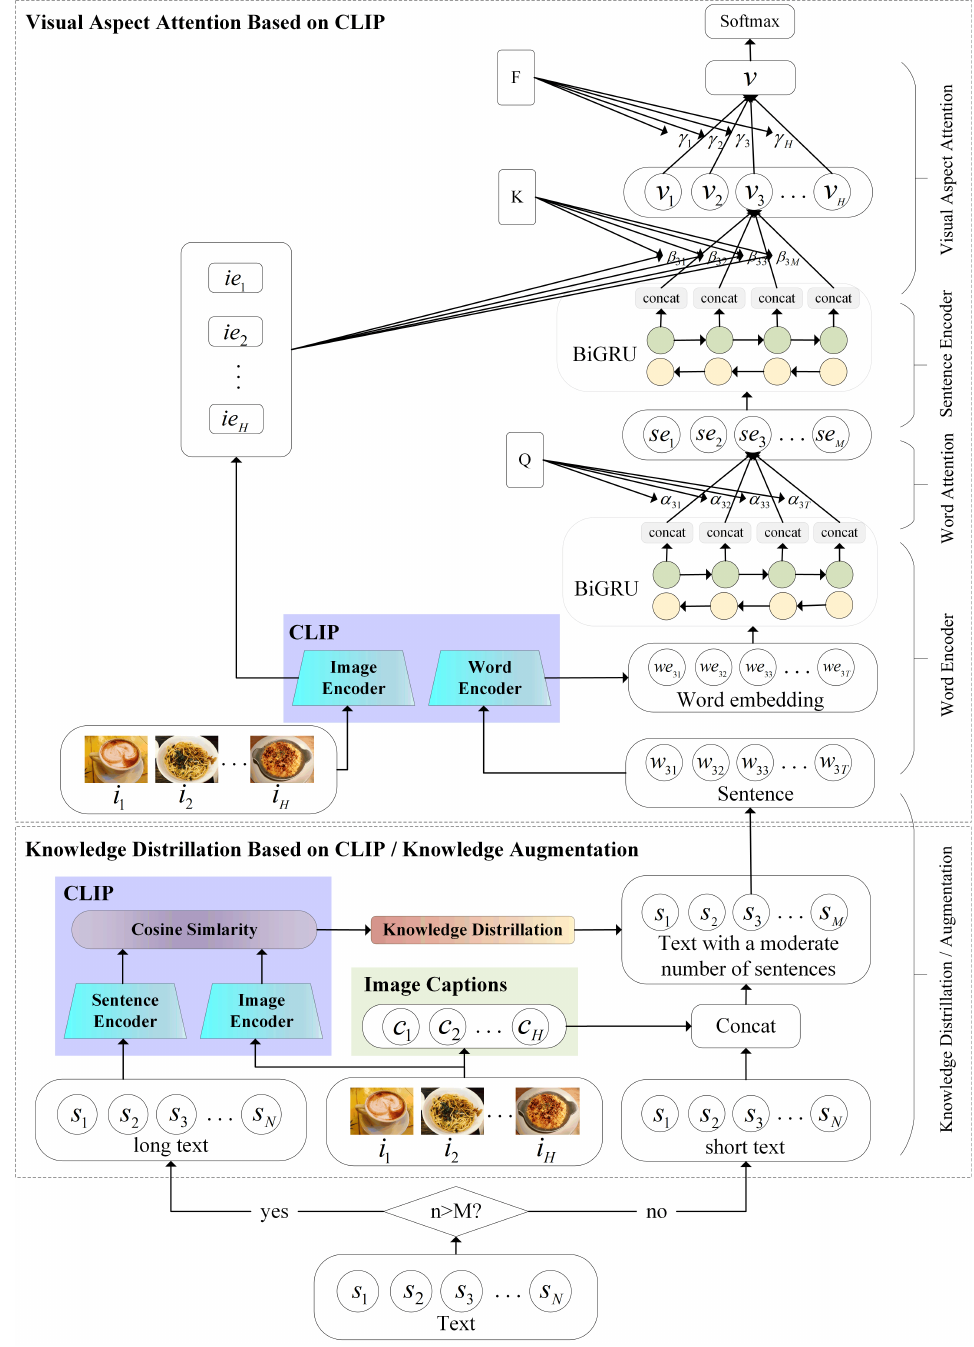
Figure 2. Structure of Visual Distillation and Attention